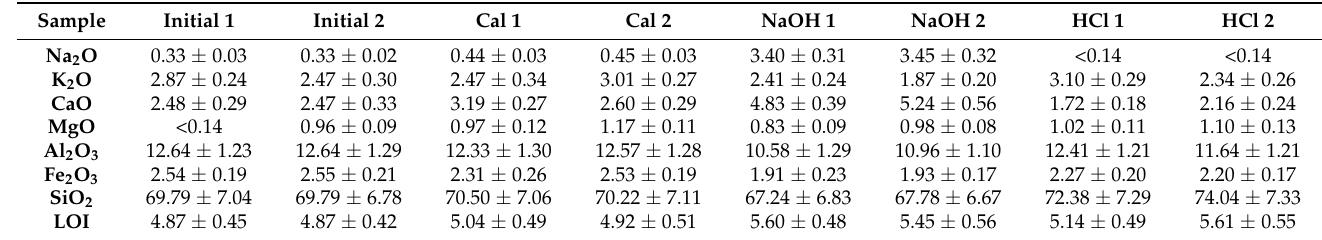
Table 4. Chemical composition (wt.%) of zeolite samples.